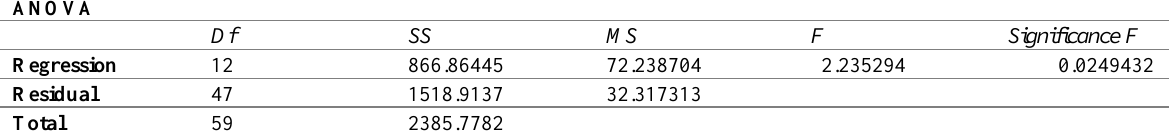
Table 14: ANOVA (Khulna Division)